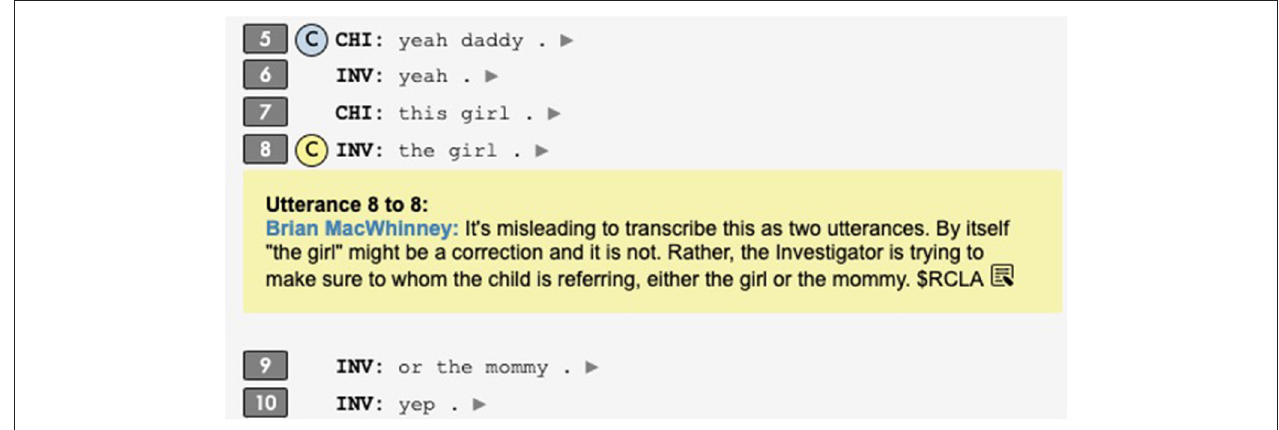
FIGURE 7 | A comment in the Collaborative Comment